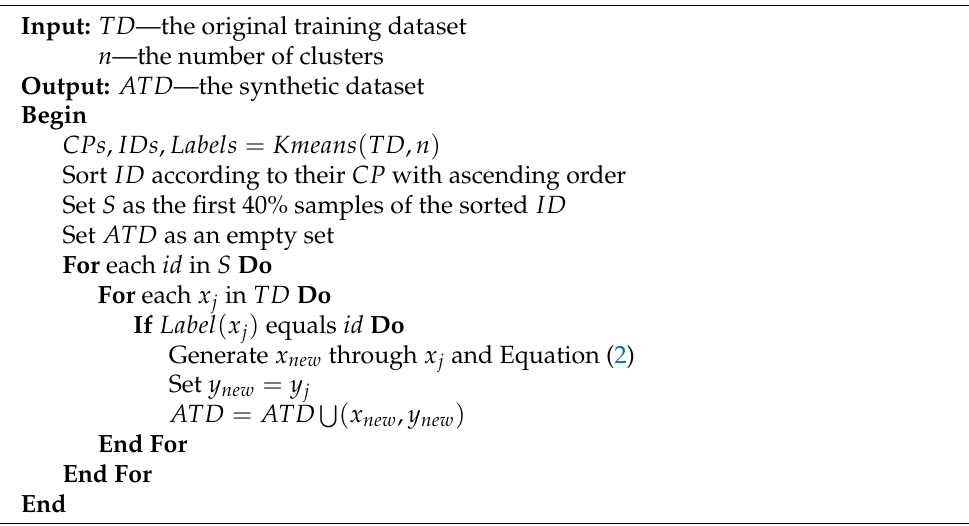
Algorithm 1 Data generation based on clustering